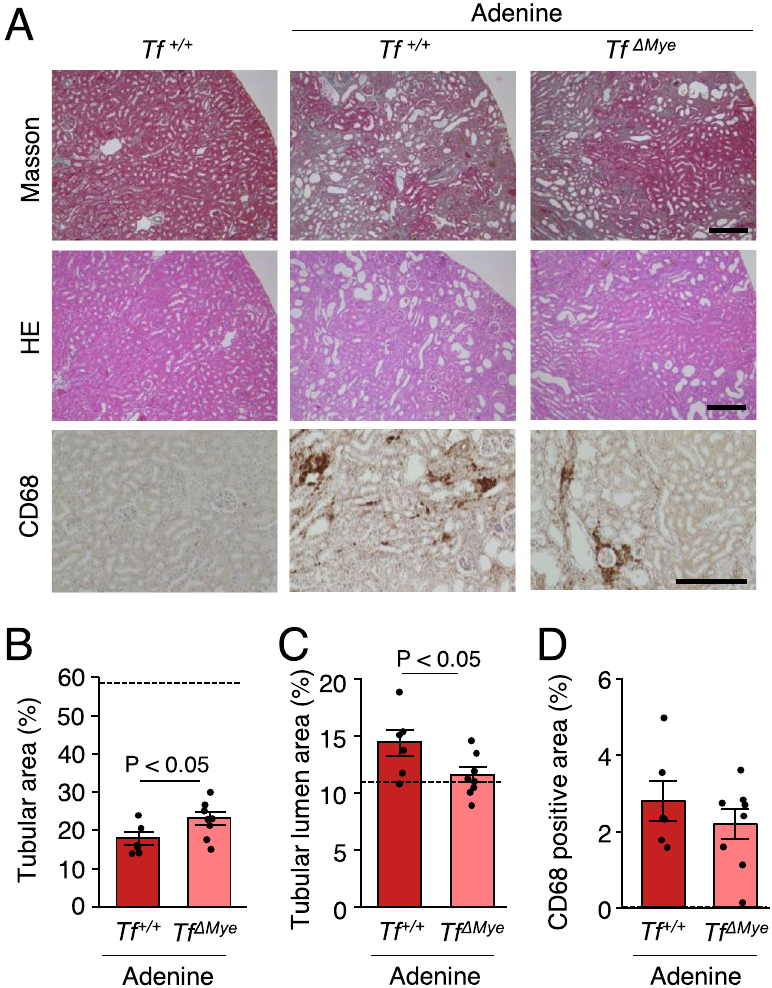
Figure 5. Myeloid TF deficiency alleviates renal tubular injury in mice fed an adenine diet. ( A ) Representative photomicrographs of Masson staining, hematoxylin and eosin (H&E) staining, and immunohistochemical staining of CD68. Comparison of the tubular area ( B ), tubular lumen area ( C ), and CD68-positive area ( D ) between Tf + / + and Tf ΔMye mice fed an adenine diet. Scale bar = 200 μm. Dotted line indicates the level of Tf + / + fed normal chow. n = 6–8. Data are shown as the mean ±